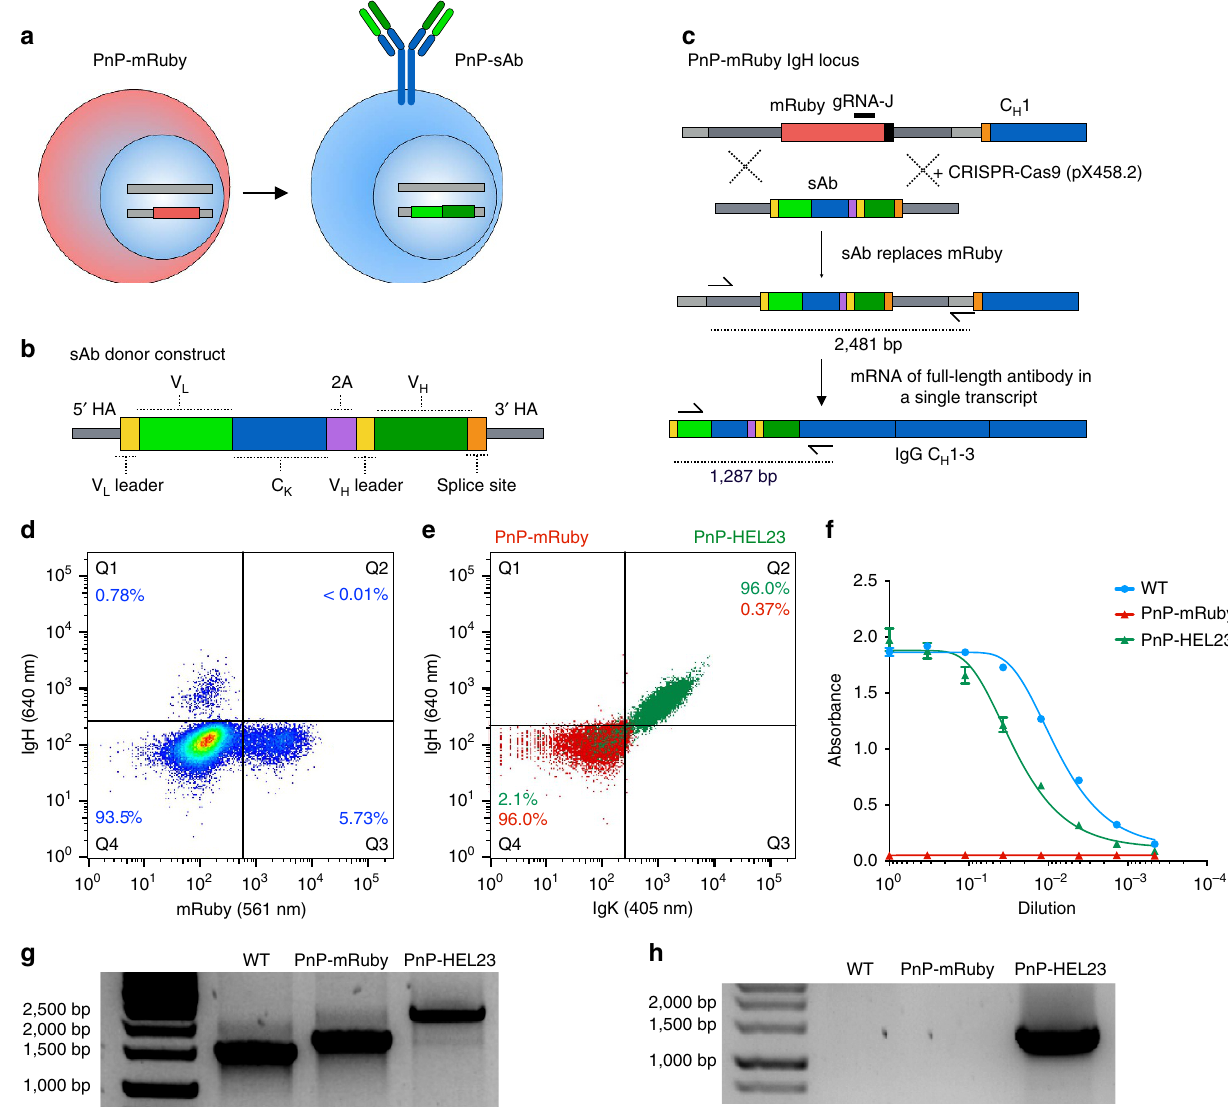
Figure 2 | PnP-mRuby hybridomas reprogrammed to surface express and secrete a new antibody. ( a ) Schematic shows PnP-mRuby cells expressing mRuby will be converted back into hybridomas expressing a new antibody via a synthetic antibody (sAb) construct. ( b ) Shown is the design of the sAb donor construct (for simplicity, introns have been excluded, for complete sequence details, see Supplementary Fig. 7). ( c ) Shown is the PnP-mRuby IgH locus where gRNA-J target site (black) is in the mRuby gene. The PnP-mRuby cells transfected with CRISPR-Cas9 plasmid and sAb donor will result in HDR-driven genomic replacement of mRuby. The new antibody will then be expressed from a single mRNA transcript. ( d ) Flow cytometry dot plot shows the different populations that emerge following transfection of PnP-mRuby with CRISPR-Cas9 plasmid and sAb donor [Hen egg lysozyme 23 (HEL23)]. The cells that were positive for IgH expression were sorted. ( e ) Flow cytometry dot plot shows initial population of PnP-mRuby cells and resulting cells (PnP-HEL23) from sorted IgH-positive population in d , which are now strongly positive for IgH and IgK expression. ( f ) Graph shows sandwich ELISA results (capture anti-IgK, primary detection anti-IgH) on hybridoma culture supernatant, PnP-HEL23 shows IgG secretion levels similar to WT. For each sample, four technical replicates were analysed and a four-parameter logistical curve was fitted to the data by nonlinear regression. Data are presented as the mean and error bars indicate standard deviation. ( g ) PCR was performed on the genomic DNA of WT, PnP-mRuby, PnP-HEL23 cells using primers shown in c . Agarose gel from genomic PCR shows the predicted band size in PnP-HEL23. ( h ) RT–PCR from mRNA was performed with primers shown in c and results in a visible band of the correct size present only in PnP-HEL23. The bands from PnP-HEL23 were extracted and Sanger sequencing confirmed correct integration of the PnP-sAb construct (see Supplementary Fig. 7). Throughout this figure, WT cells correspond to clone WEN1.3, PnP-mRuby cells correspond to clone 1E9.C3, and PnP-HEL23 cells correspond to clone Y (for more details, see Supplementary Table